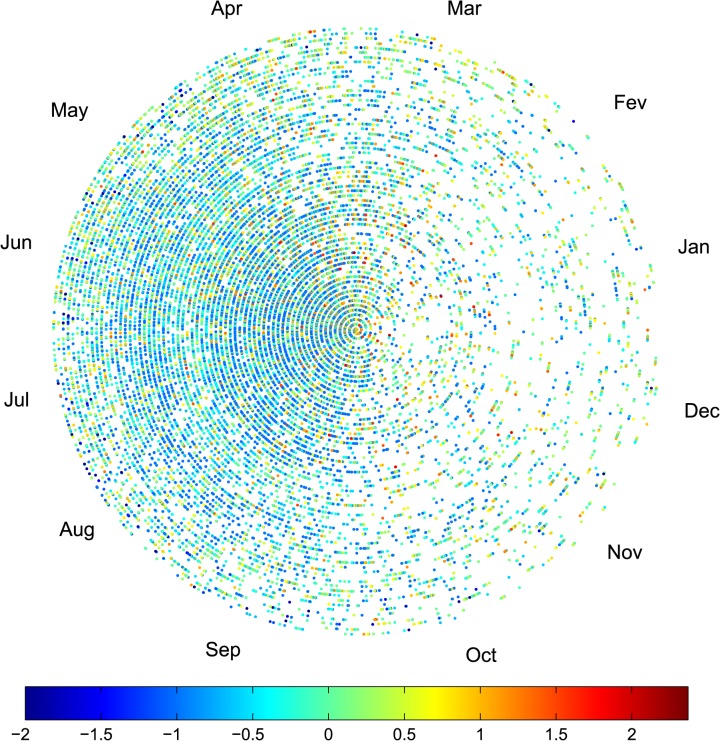
Temporal evolution and intensity (in log units) of the events occurred in the U.S. during the time period 1950–2013.The coordinates (r, ϴ) represent the circular (spiral) time of the events and the colors represent the intensity, measured by L (in log units).